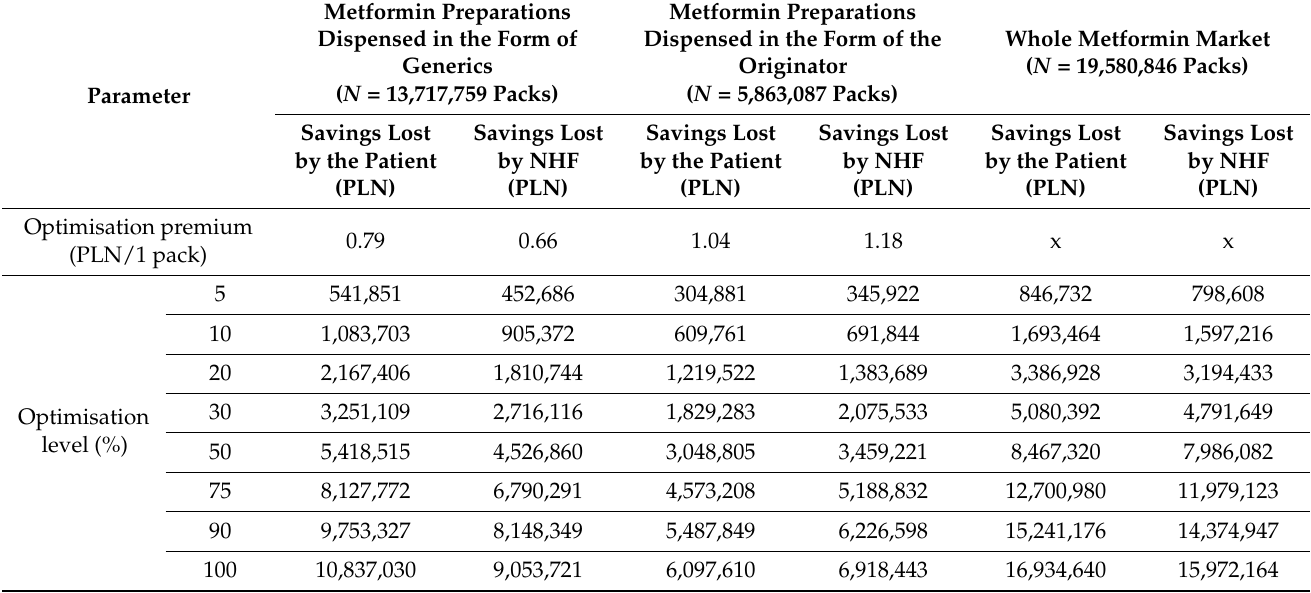
Table 4. Lost savings due to suboptimal implementation of generic substitution of metformin preparations prescribed and dispensed in Poland in 2019 (data refer to the dispensation period between 1 January–31 December 2019); NHF—National Health Fund; PLN—Polish